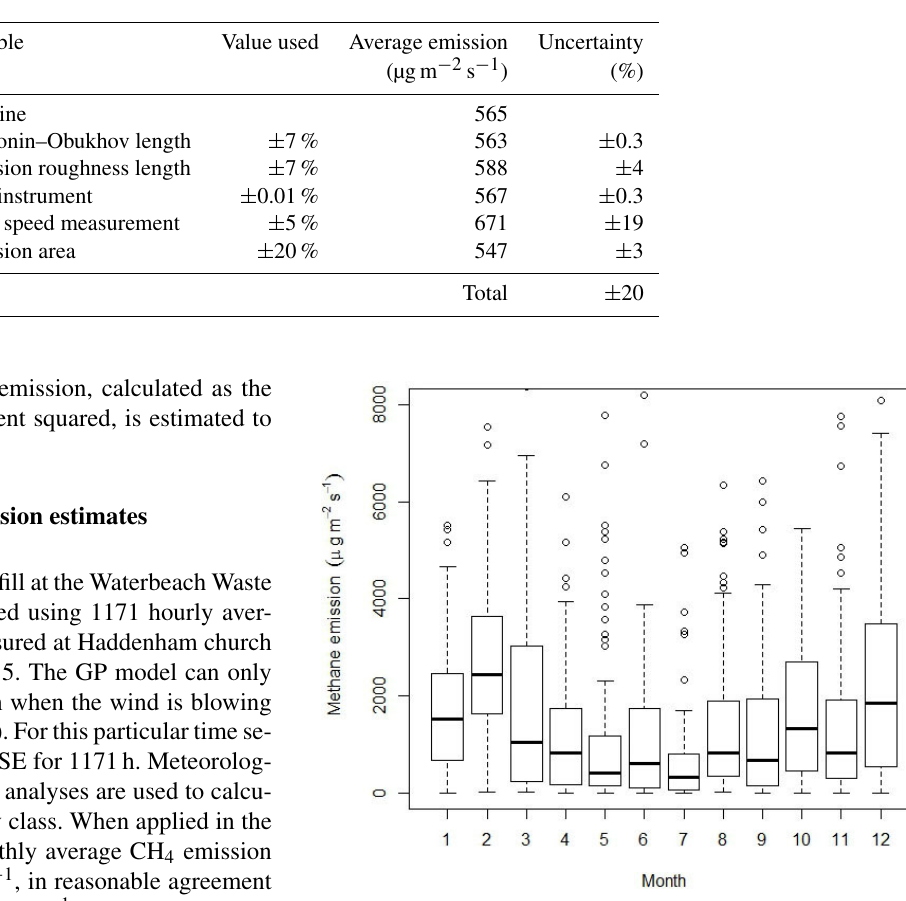
Table 2. Uncertainty analysis conducted on the case study (June 2015) for methane emission from the landfill at the Waterbeach Waste Management Park as calculated within the WindTrax atmospheric dispersion model.